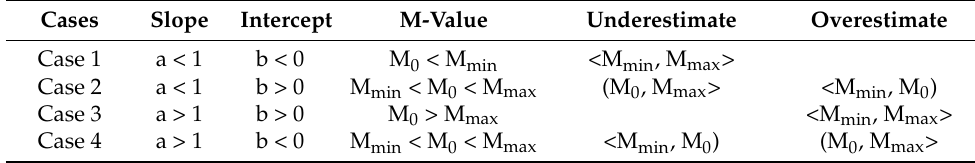
Table 2. Assessment of model prediction